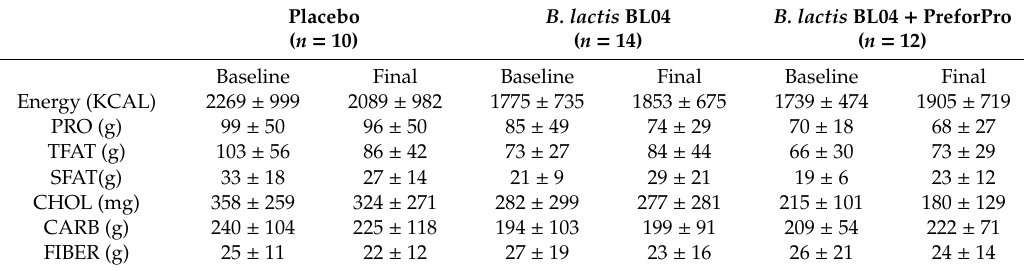
Table 4. Self-reported dietary